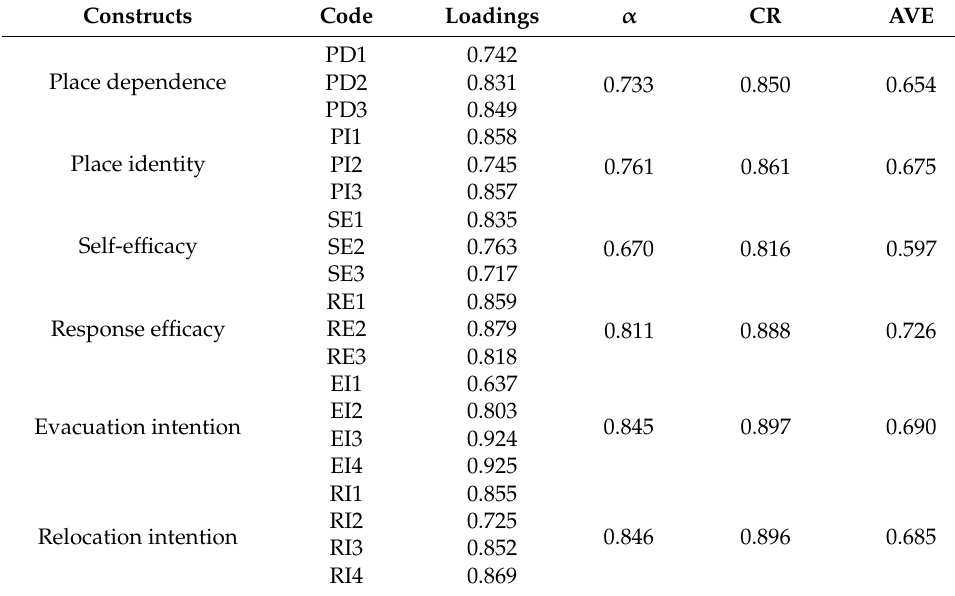
Table 3. Assessment of construct validity.